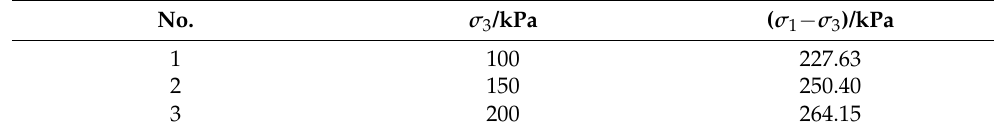
Table 3. ( σ 1 − σ 3 ) at the failure point under each σ 3 in the triaxial shear tests. No.